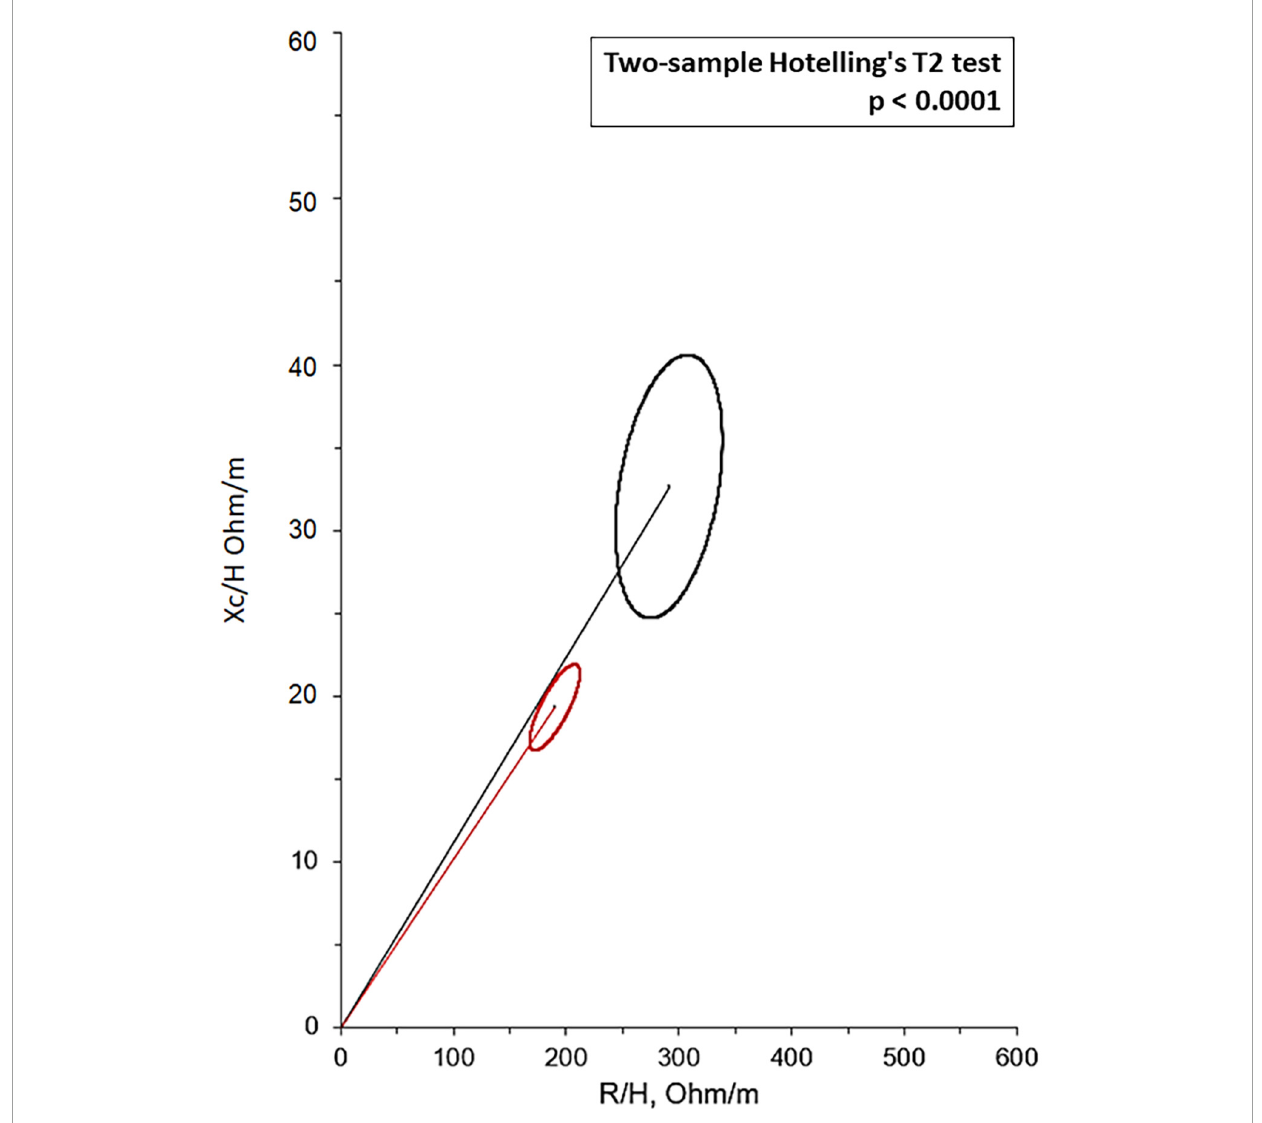
FIGURE3 Mean Biavectors from overhydrated (red ellipse) and normohydrated patients (black ellipse), recorded the day before the start of SGLT2i (T0), compared with the two-sample Hotelling’s T2 test ( p <